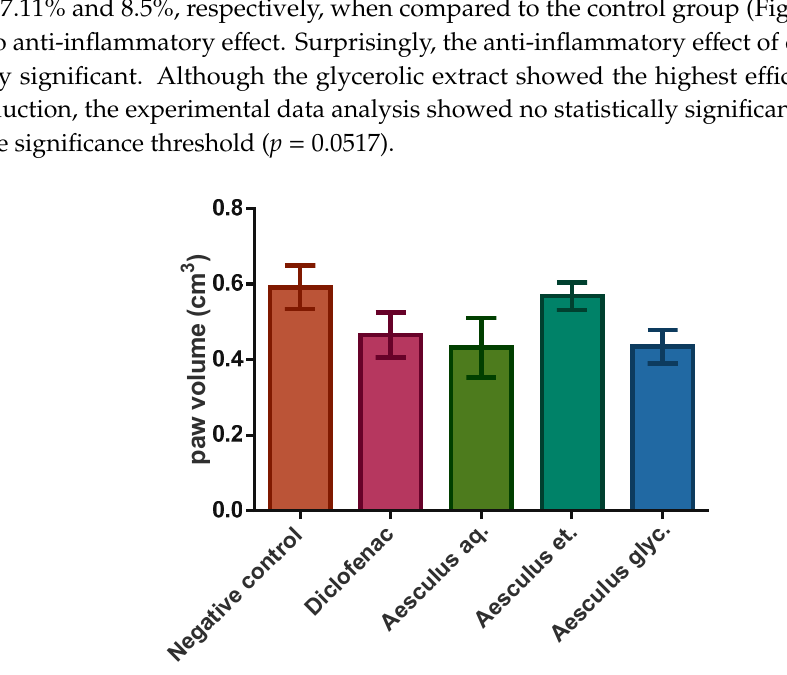
Figure 5. Difference of paw volume between initial and final measurements in the kaolin inflammation model (mean ± SD). The A. hippocastanum ethanolic extract showed no significant anti-inflammatory effect ( p > 0.05). Diclofenac sodium and the A. hippocastanum aqueous extract reduced paw edema, but the differences were not statistically significant ( p > 0.05). The A. hippocastanum glycerolic extract showed a statistically insignificant anti-inflammatory effect ( p = 0.0517).